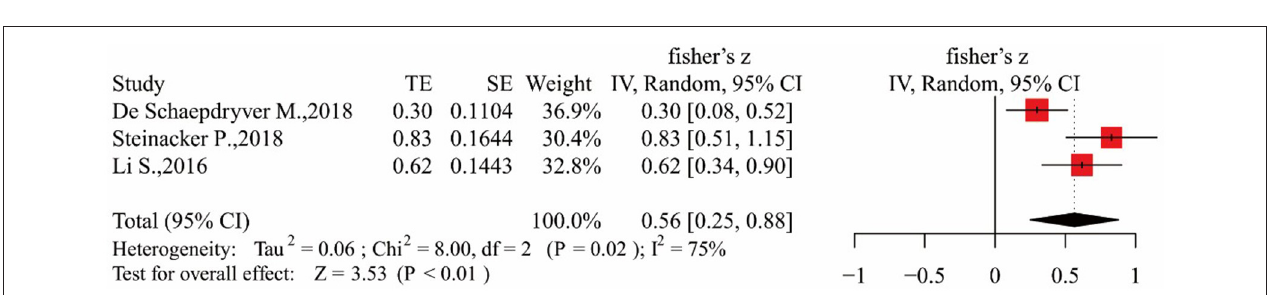
FIGURE 7 | Forest map showing the relationship between pNfH levels and